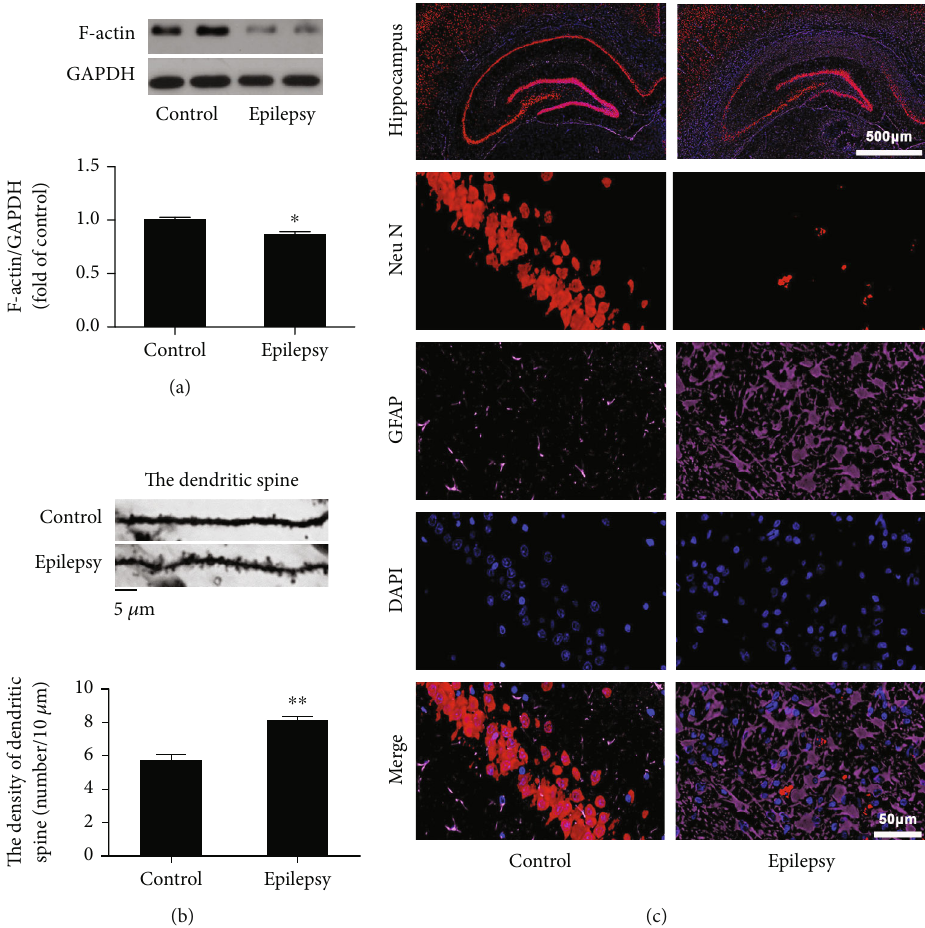
Figure 4: Increased dendritic spines and gliosis in the hippocampus of TLE rats. (a) The expression and quantitative analysis of F-actin in hippocampus; (b) the density of dendritic spines in the dentate gyrus of hippocampus; (c) the expression of GFAP and NeuN in the CA1 region of hippocampus. ∗ P < 0 : 05 , control vs. epilepsy ( mean ± SD , n = 5 ). n refers to the numbers of